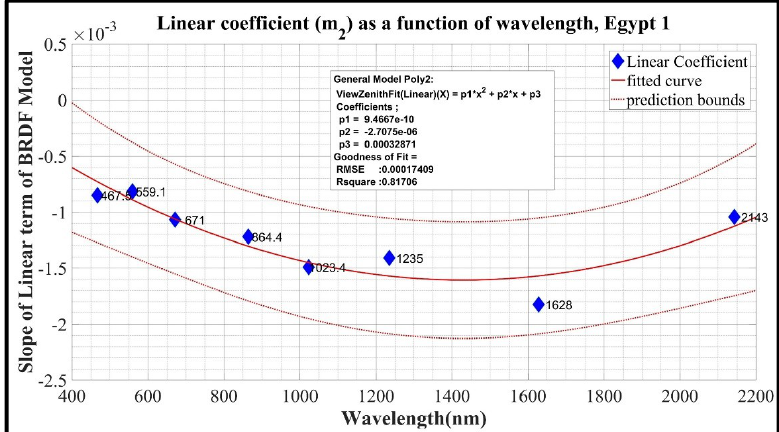
Figure 5. Quadratic model fit on linear coefficient as a function of wavelength for Egypt 1.